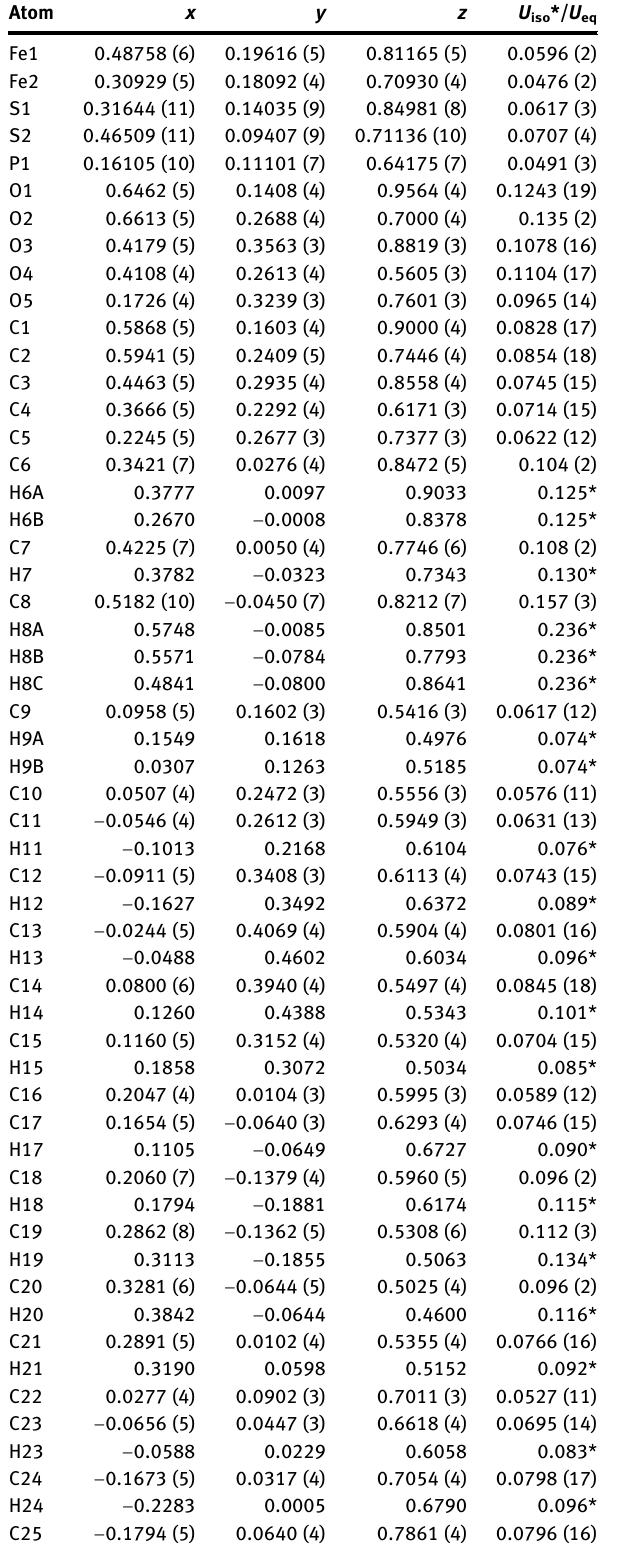
Table  : Fractional atomic coordinates and isotropic or equivalent isotropic displacement parameters (Å 